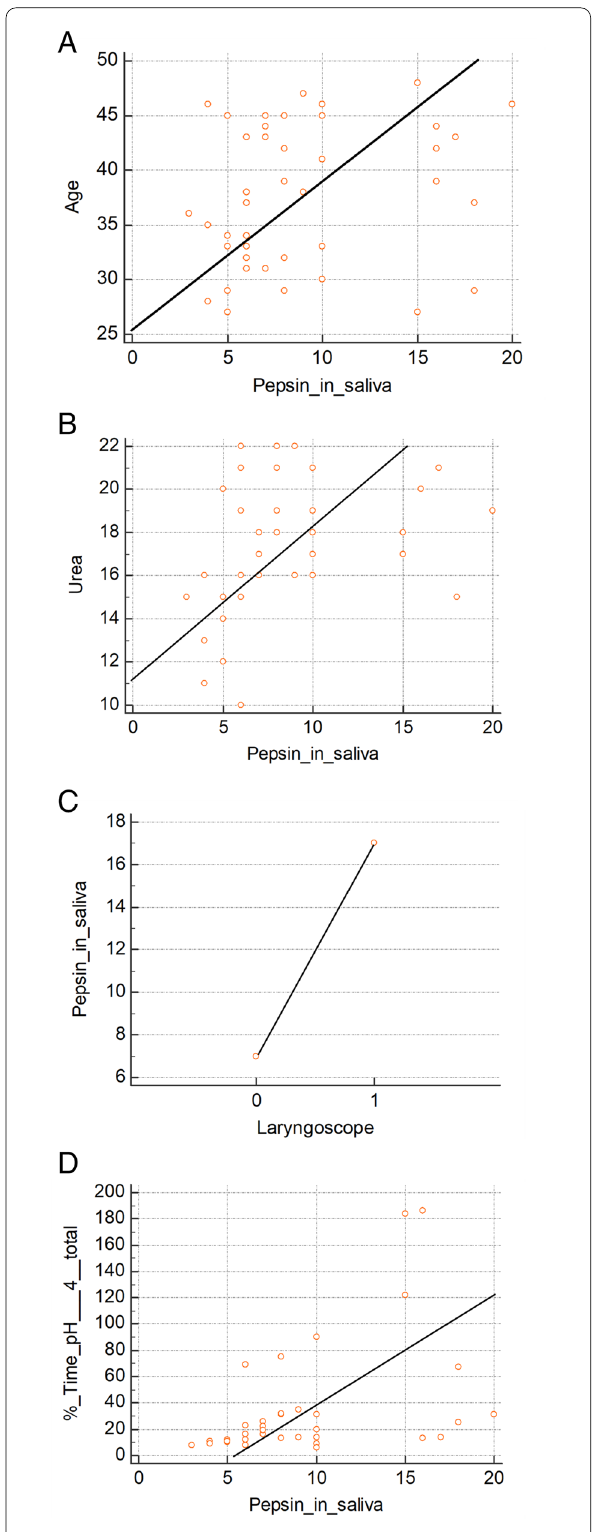
Fig. 2 A Correlation between salivary pepsin and age. B Correlation between salivary pepsin and urea. C Correlation between salivary pepsin and laryngoscope abnormality. D Correlation between salivary Pepsin and pH-metry (% Time pH <